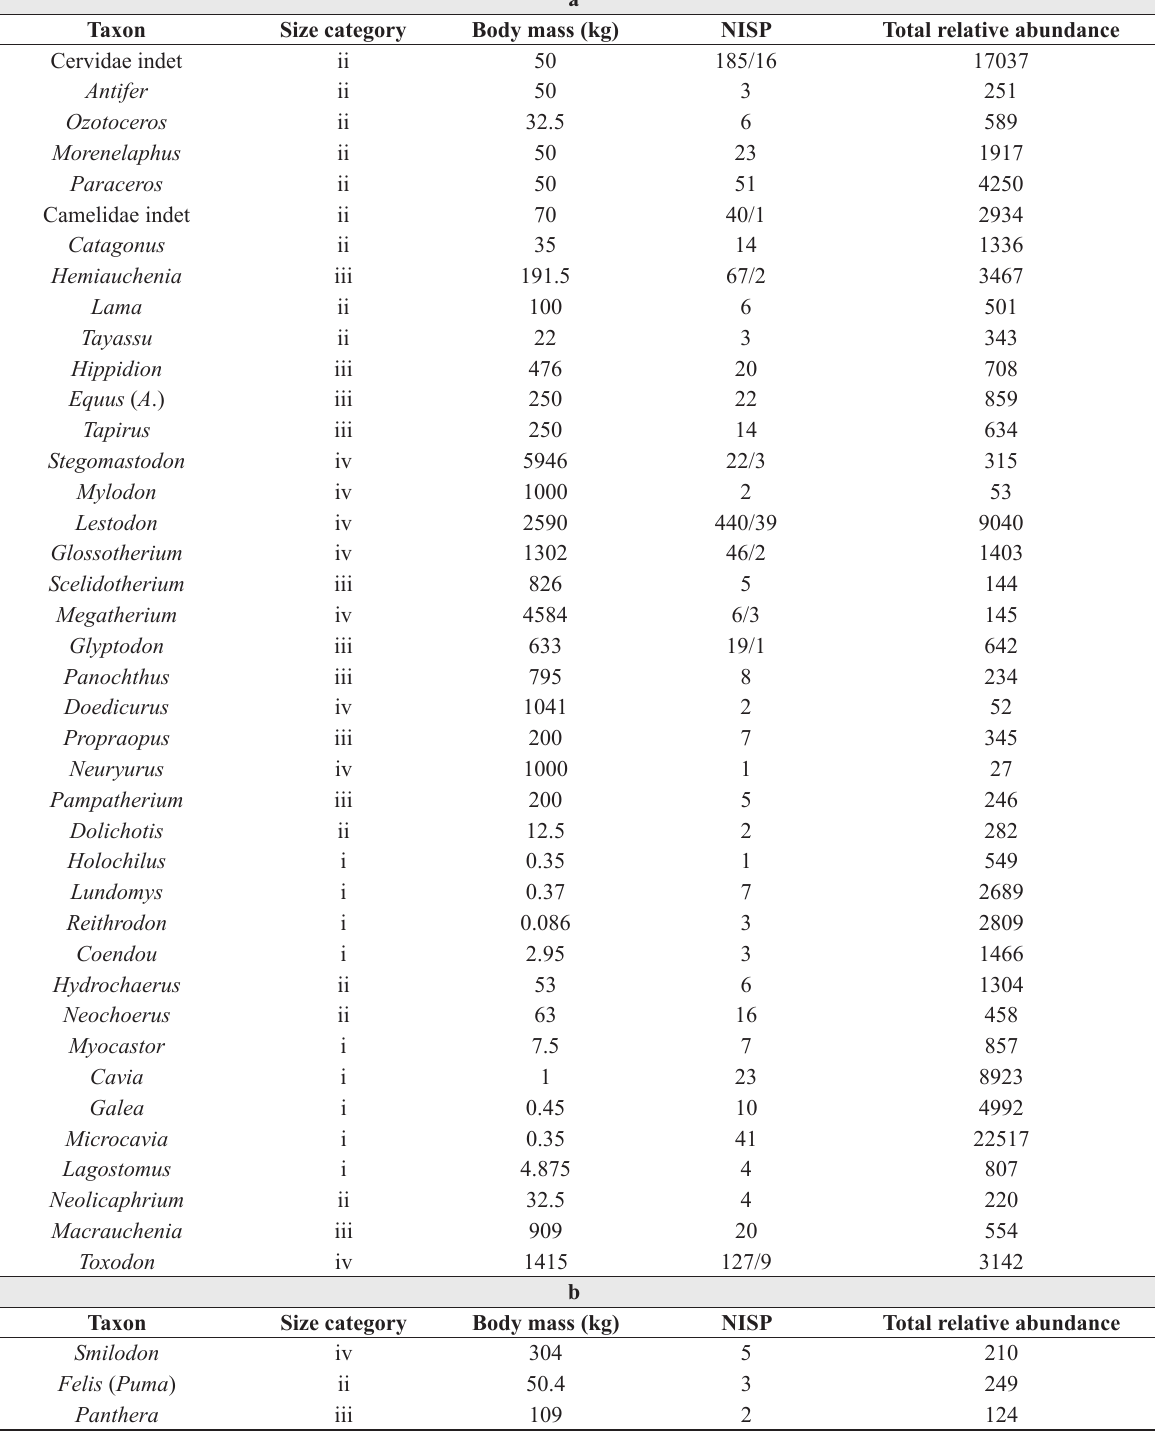
Taxa counts of primary (a) and secondary (b) consumers in the considered sample for Uruguay, including size category, estimated body mass, number of specimens (adults/juveniles, NISP) and estimated relative